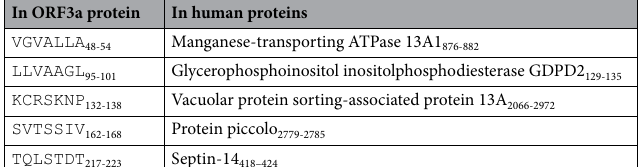
In ORF3a protein